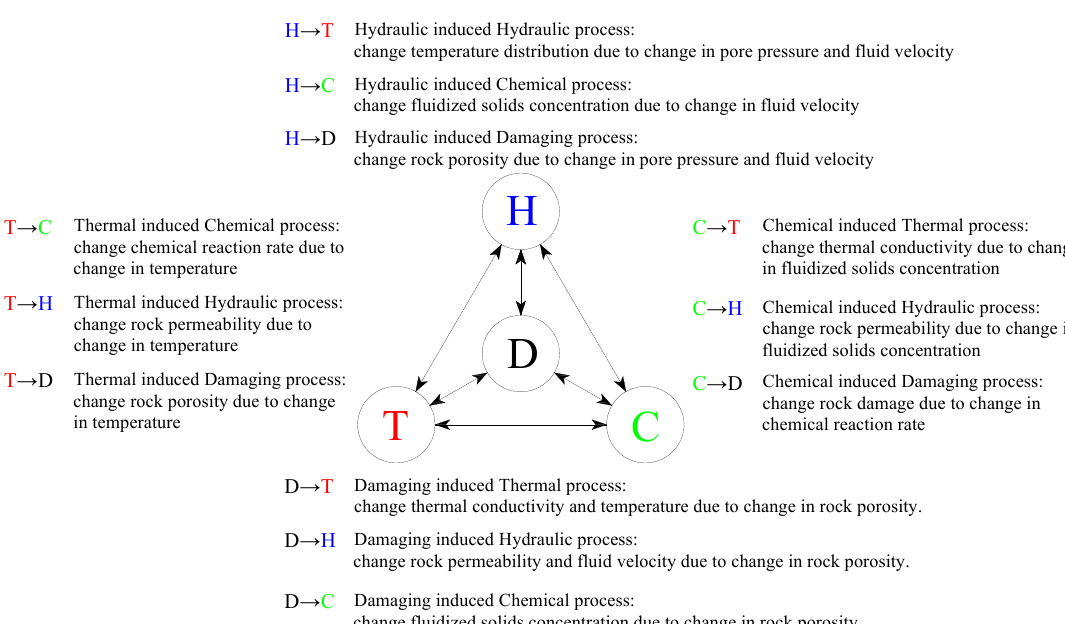
Figure 1. The coupled thermal–hydraulic–chemical (THC) processes for heterogeneity rock damage.